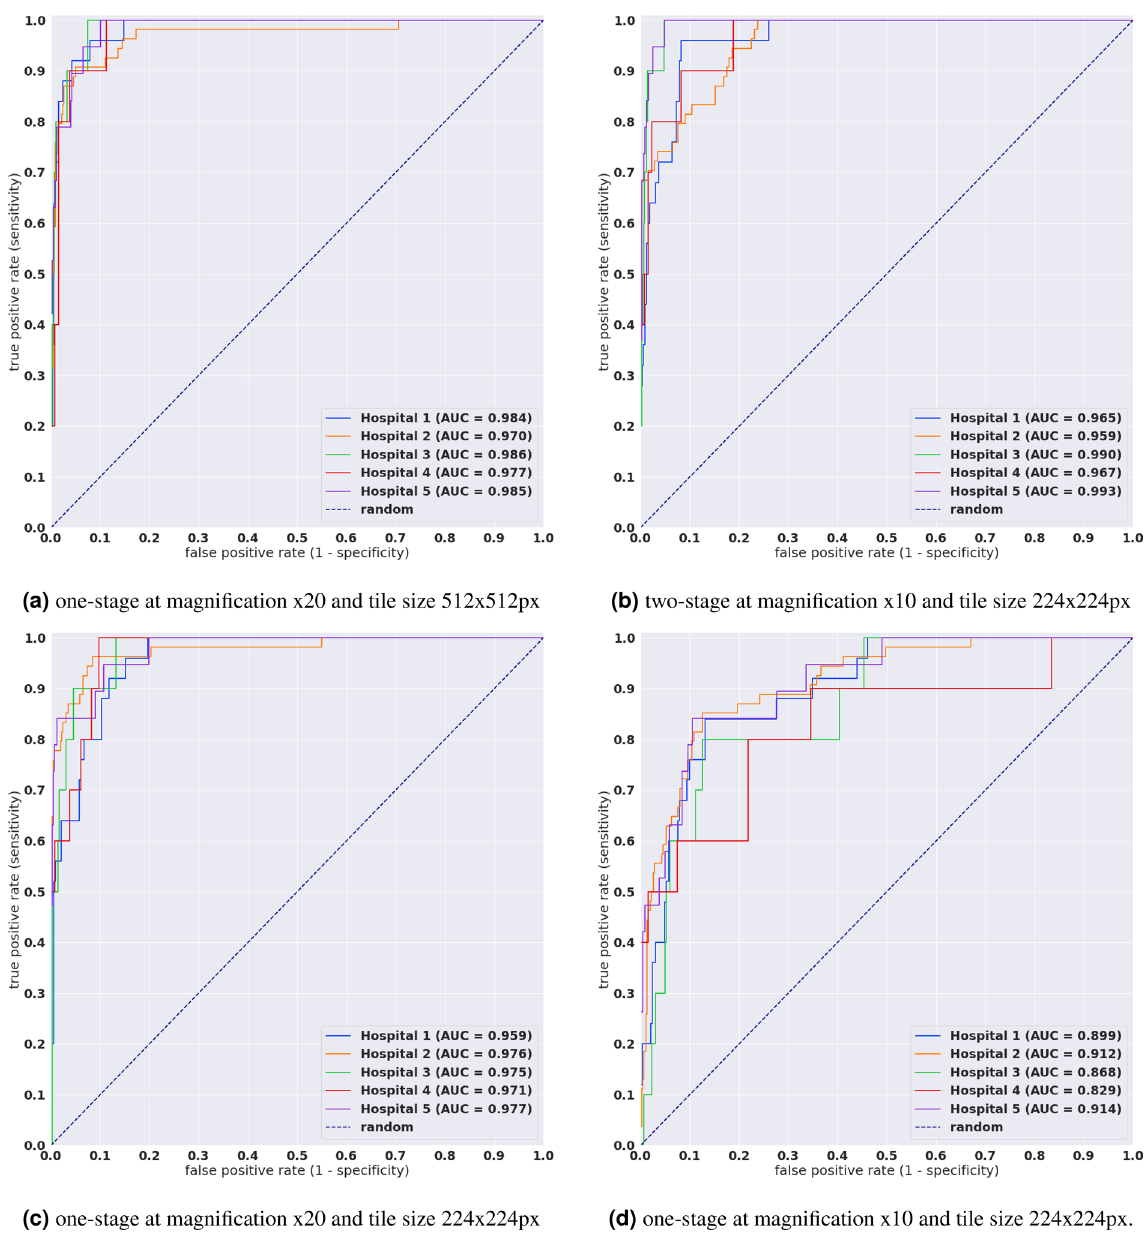
Figure 2. ROC curves and corresponding AUCs for the test sets from five different hospitals using four different